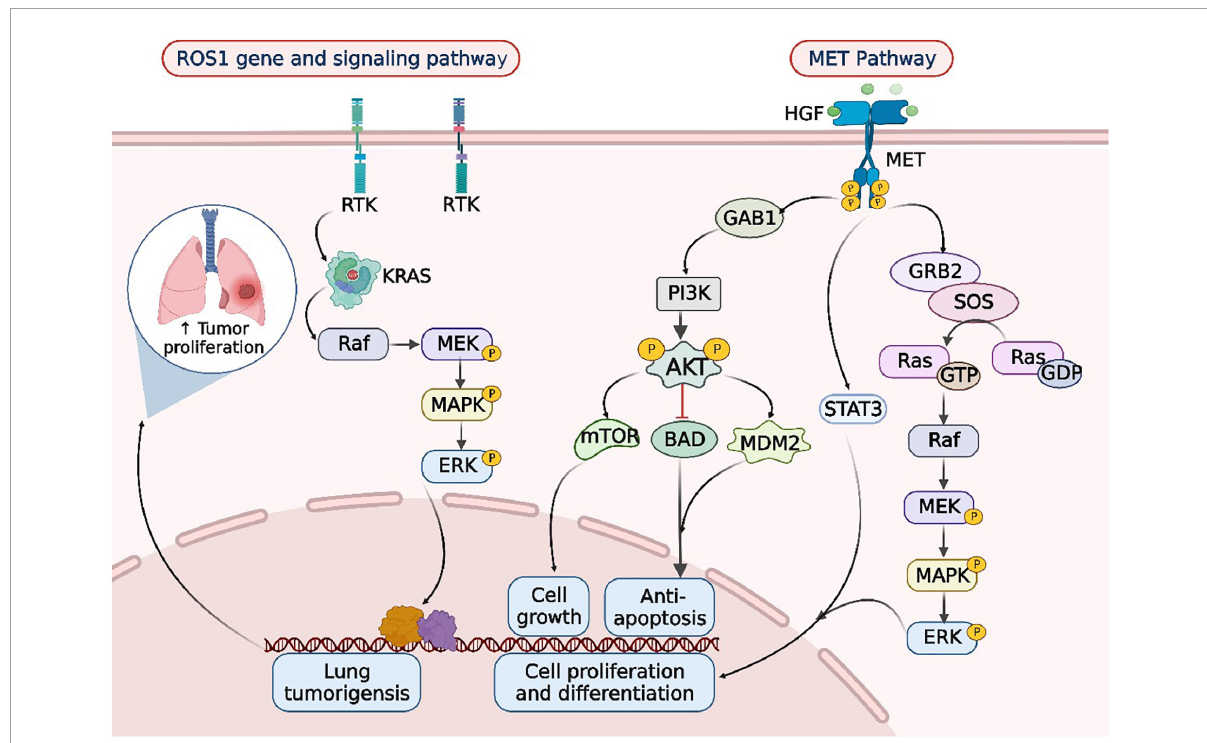
FIGURE2 ROS1 rearrangements and MET mutations in the occurrence and development of lung cancer. When lung cancer is developed, the tyrosine kinase receptor (RTK) encoded by the ROS1 gene synergizes with oncogenic drivers such as KRAS to enhance MAPK-ERK signaling. Upon MET activation, PI3K associates with GAB1 and activates AKT/protein kinase. AKT inactivates the pro-apoptotic protein BCL-2 cell death antagonist (BAD) and triggers the E3 ubiquitin-protein ligase MDM2, thereby inhibiting apoptosis and promoting cell survival. In addition, AKT activates the mammalian target of rapamycin (mTOR) protein, promoting protein synthesis and cell growth, MET activation signals through the RAS-MAPK pathway as well. The nucleotide exchange protein Son of Sevenless (SOS) activates RAS upon binding to GRB2, which leads to activation of the v-Raf murine sarcoma viral oncogene homolog B1 (RAF) kinase, followed by stimulation of MAPK effector kinase (MEK) and resulting in MAPK activation. MAPK phosphorylates ERK, the ultimate effector of the cascade. The RAS-MAPK pathway is responsible for cell proliferation, cell motility, and cell cycle progression. Moreover, MET could relay signals to the activator of the transcription 3 (STAT3) pathway. STAT3 directly binds to MET, enabling STAT3 phosphorylation, which regulates cell transformation and invasion. RTK, receptor tyrosine kinases; Raf, rheumatoid arthritis factor; MEK, MAP kinase-ERK kinase; ERK, extracellular regulated protein kinases; HGF, hepatic growth factor; MET, mesenchymal to epithelial transition factor; GAB1, Grb2-associated binders 1; GAB2, Grb2-associated binders 2; PI3K, phosphoinositide-3 kinase; AKT, protein kinase B; mTOR, mammalian target of rapamycin; BAD, Bcl-xL/Bcl-2 associated death promoter; MDM2, murine double minute 2; SOS, son of sevenless; GTP, guanosine triphosphate; GDP, guanosine diphosphate; STAT3, signal transducer and activator of transcription